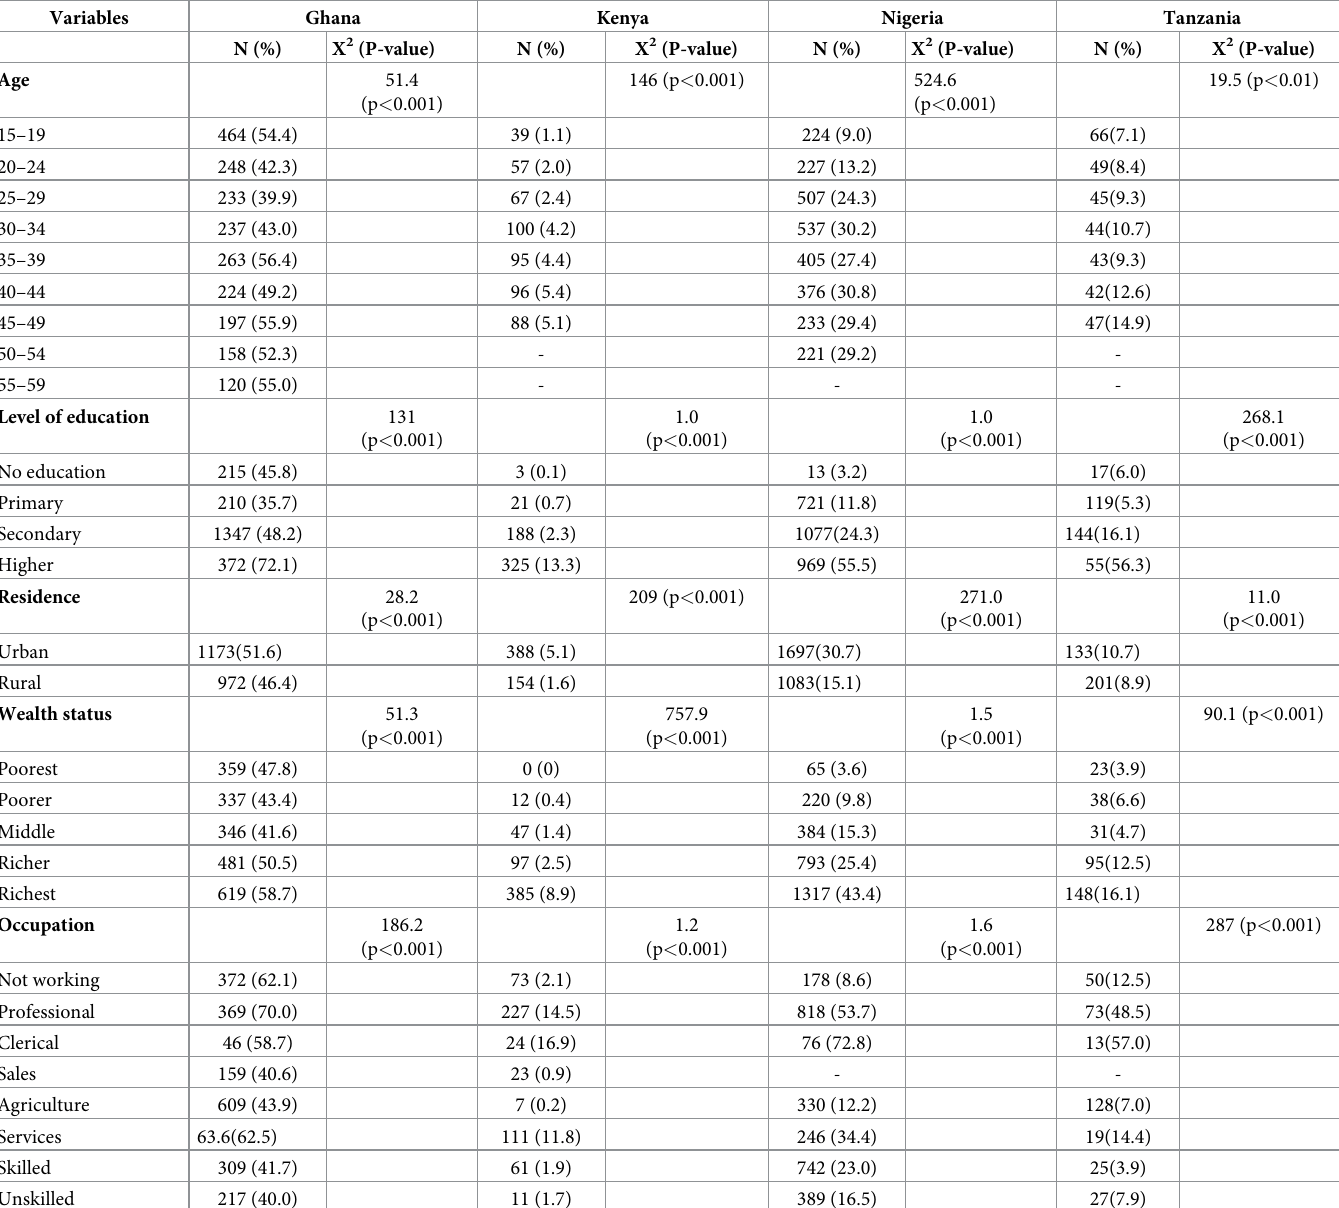
Table 2. Socio-economic characteristics of respondents and health insurance coverage